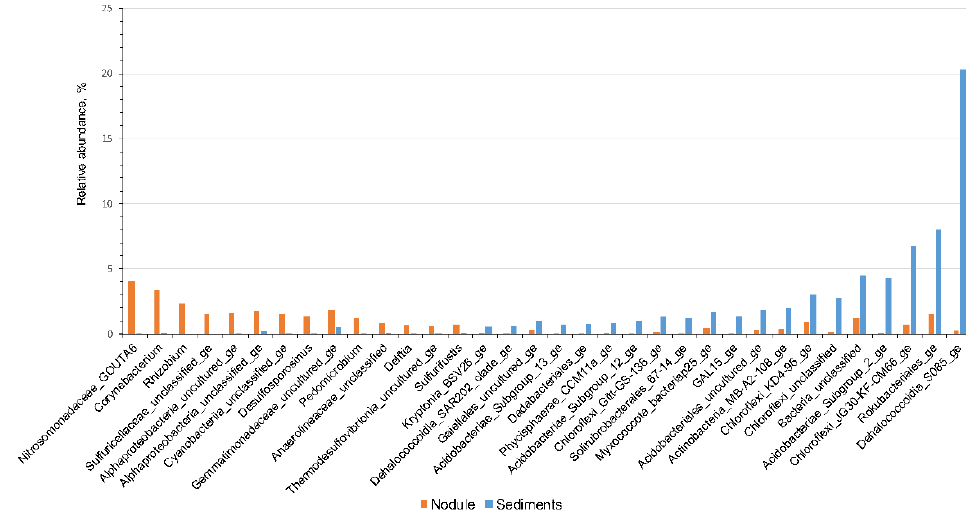
Figure 9. OTUs 0.03 with relative abundance > 0.5% (on average for sediments and in absolute values for the nodule) and difference in relative abundance between the nodule and sediments by a factor of three or more.